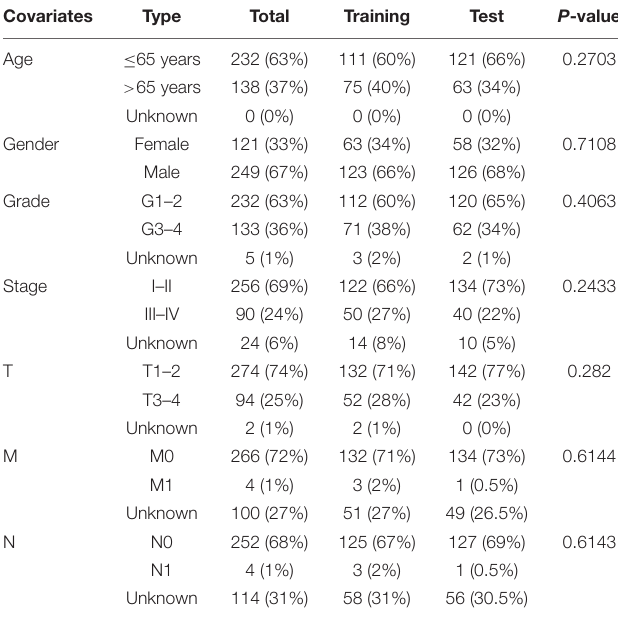
TABLE 1 | Clinicopathological parameters of HCC patients in the training, test, and TCGA data